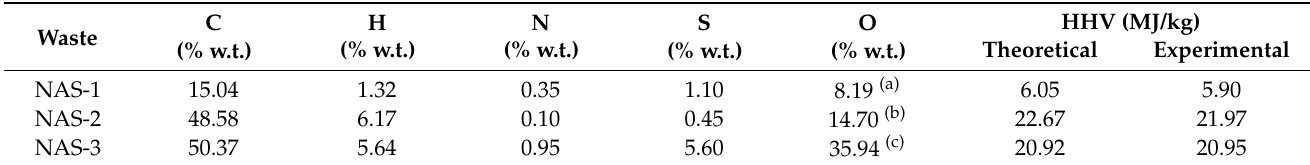
Table 1. Elemental analysis of waste materials and theoretical HHV values (relative standard devia- tion